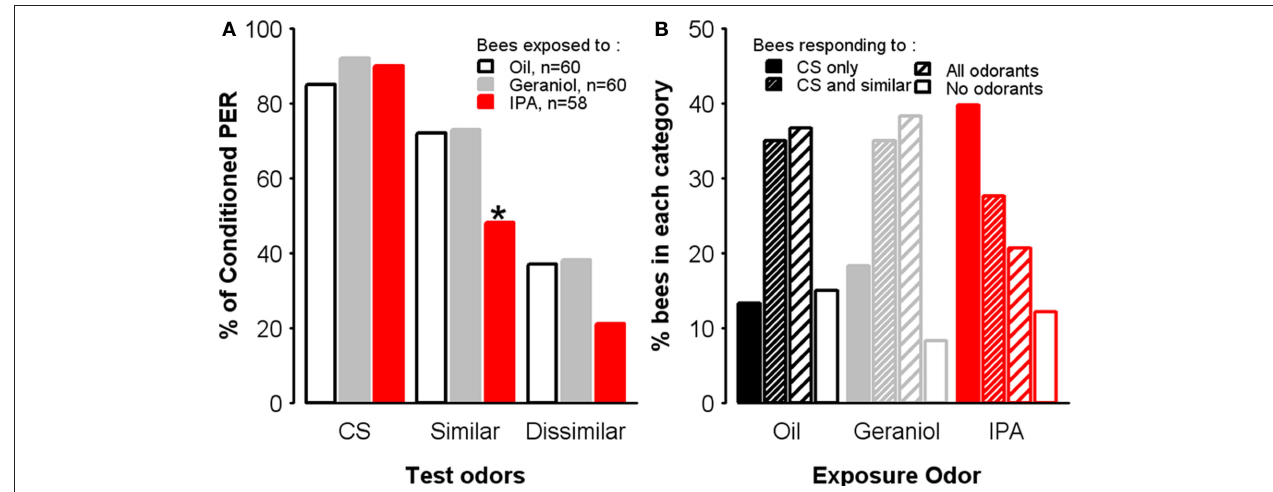
Figure 8 | exposure to iPA affects olfactory generalization. Learning performances, as indicated by percentages of conditioned PER to the conditioned odor on the third conditioning trial, for each group. Independent groups of bees were exposed to oil, geraniol, or IPA, immediately after conditioning, and then tested 1 h after the end of conditioning. Generalization was assessed by measuring PER in response to unrewarded presentations of 1-nonanol (CS), nonanal (an odorant perceptually similar to 1-nonanol) and